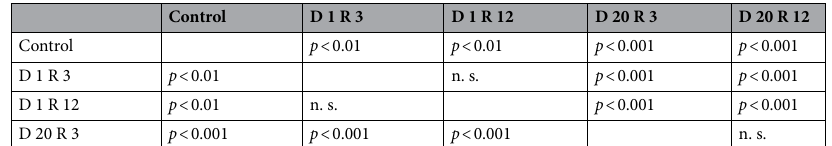
Table 1. Statistical comparisons (one-way ANOVA, Tukey post-hoc test) among fluorescence signals emitted by the storage cells of Paramacrobiotus spatialis at different experimental conditions. The total number (n) of measured cells is: Control, n = 138; D 1 R 3, n = 46; D 1 R 12, n = 78; D 20 R 3, n = 78; D 20 R 12, n = 36 (see Table S1). D 1 = animals kept in a desiccated state for 1 day, D 20 = animals kept in a desiccated state for 20 days, R 3 = 3 h after the rehydration process, R 12 = 12 h after the rehydration process, n.s. = not